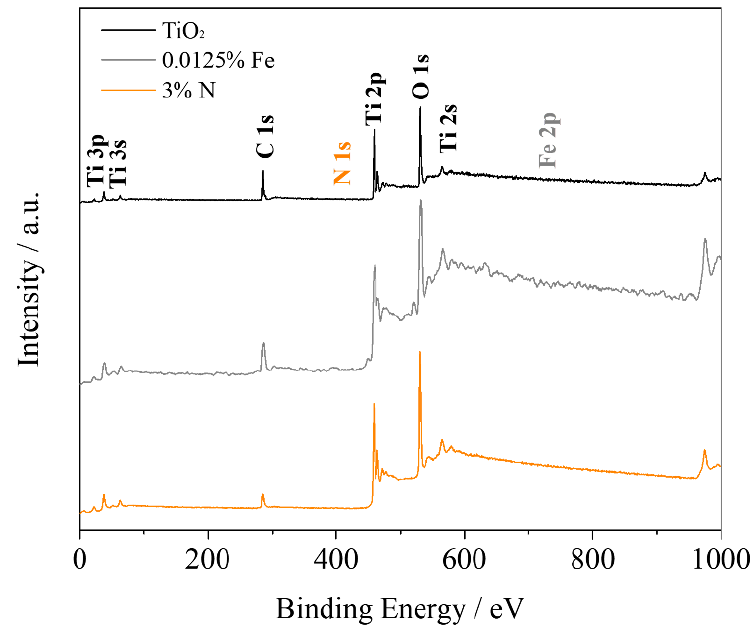
Figure 6. XPS spectra for the TiO 2 , 0.0125% Fe, and 3%N samples.